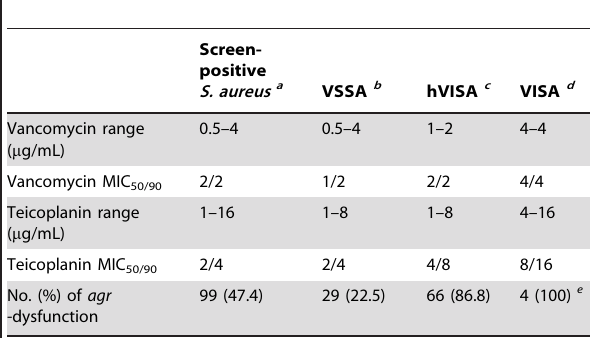
Table 3. MIC 50/90 determined by CLSI broth microdilution and the prevalence of agr